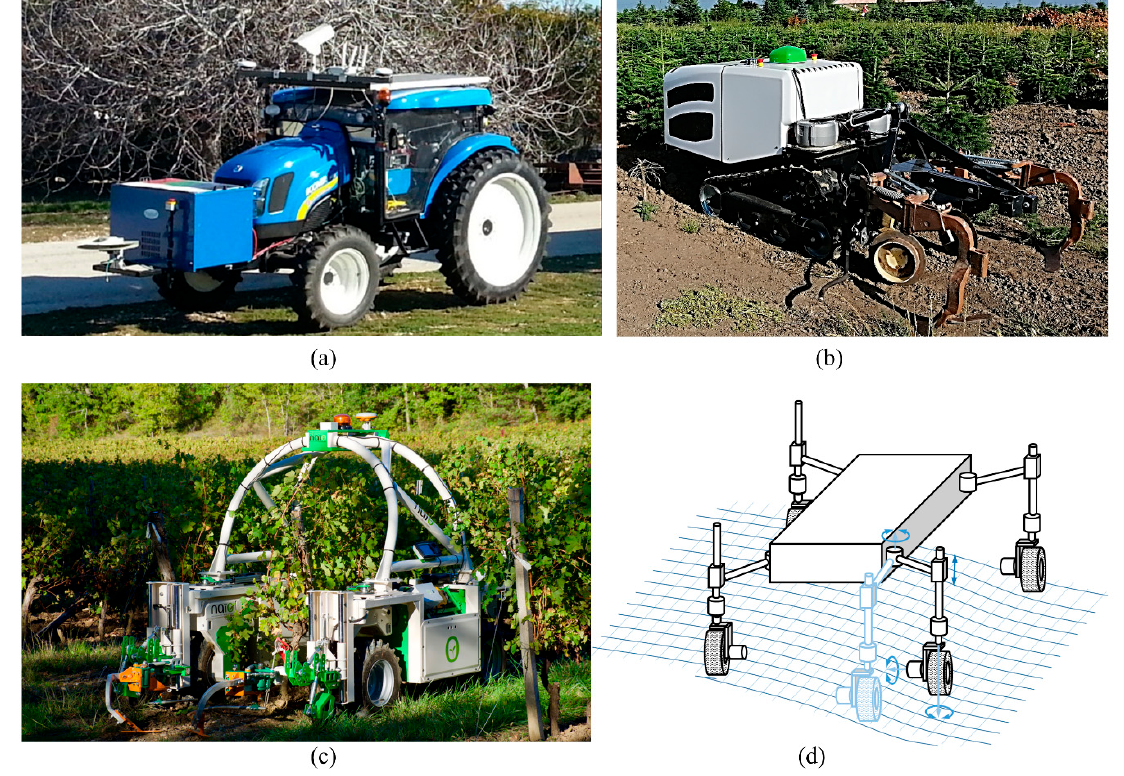
Figure 9. Mobile platform structures: ( a ) front steering wheels and rear traction wheels (RHEA prototype); ( b ) skid steering wheels (courtesy of AGREENCULTURE); ( c ) independent steering wheels (courtesy of Naïo Technologies); and ( d ) a wheel-legged prospective structure.